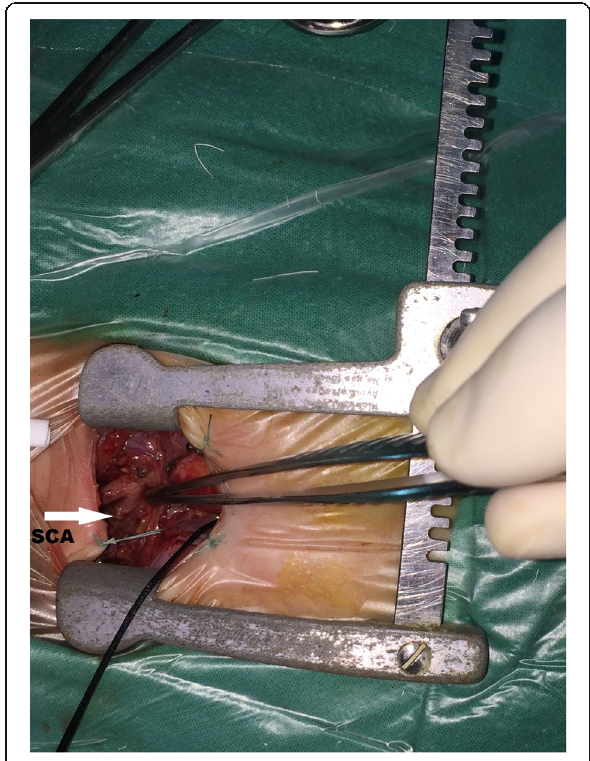
Fig. 2 Operative view showing the right subclavian artery via the ministernotomy approach. SCA subclavian